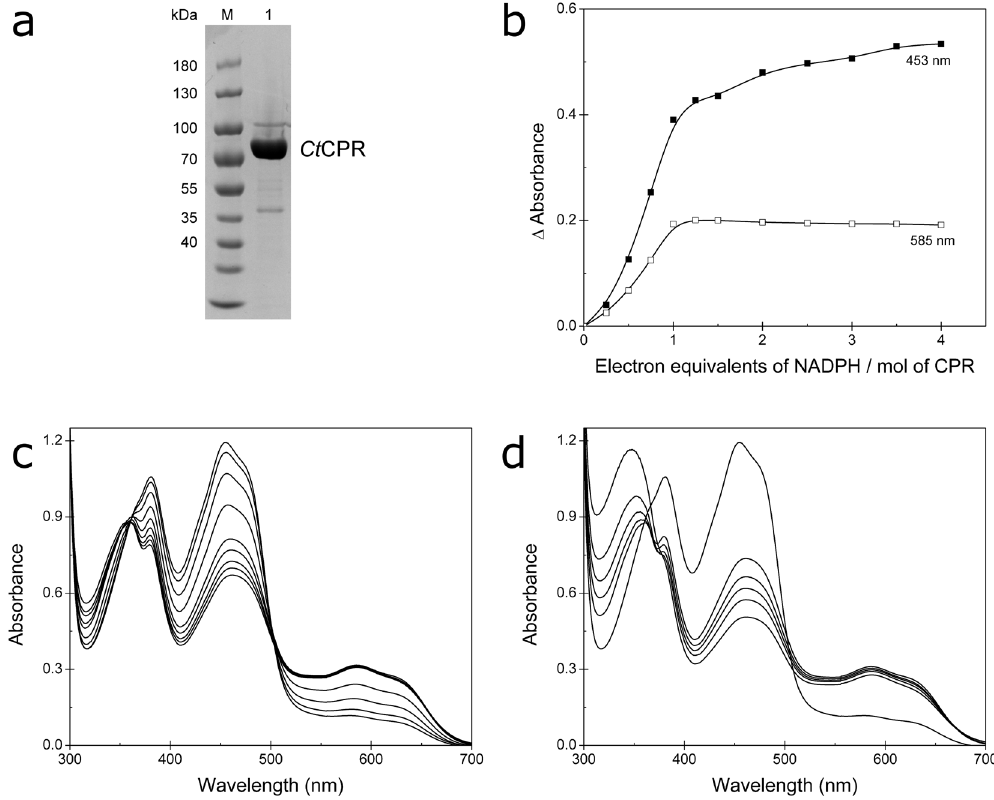
Figure 1. ( a ) SDS-PAGE of purified Ct CPR (lane M: molecular weight marker, lane 1: Ct CPR after three-step purification). ( b ) Changes in absorbance at 453 nm and 585 nm peaks after addition of different equivalents of the cofactor. ( c ) Spectral properties of Ct CPR. Changes in absorbance were recorded after the addition of NADPH (up to four equivalents per mol of CPR). ( d ) Spectral change after addition of excess NADPH (more than four electron equivalents per mol of